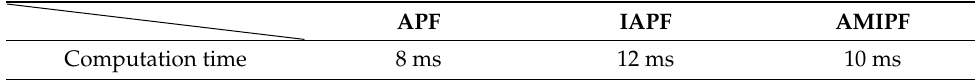
Table 5. Average computation